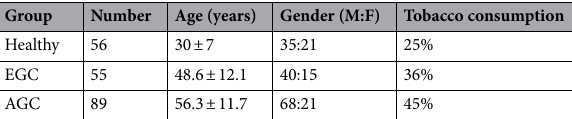
Table 2. Clinical characteristics of